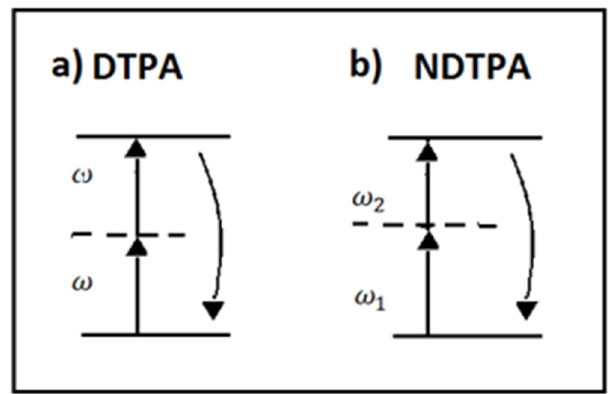
Figure 7. The energy level diagram describing the interactions: ( a ) degenerate TPA and ( b ) nondegenerate TPA.